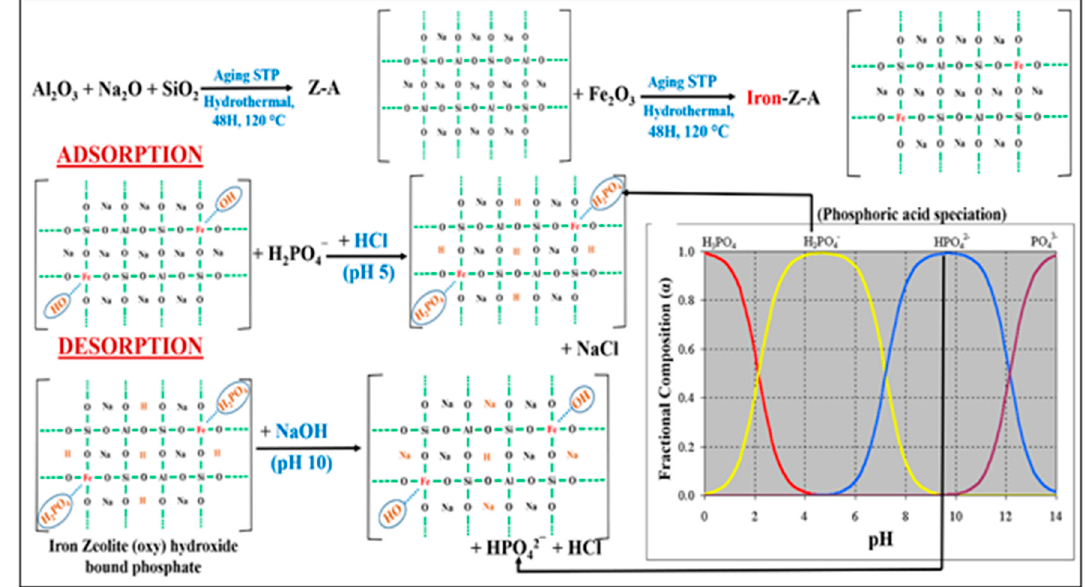
Figure 8. The above figure explains the interacting mechanism behind adsorption and desorption of phosphate on the surface of iron incorporated Iron-Z-A.